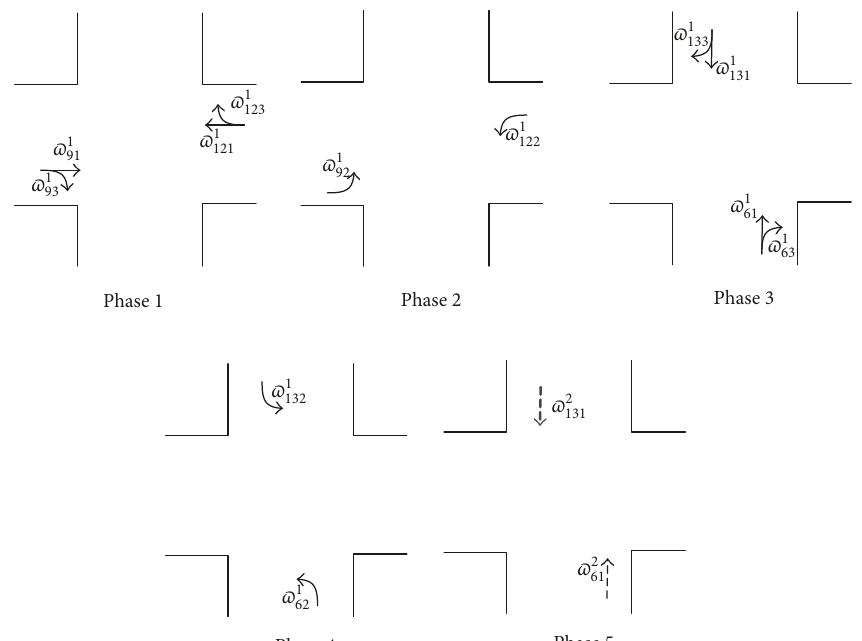
Figure 3: Five-phase signal control strategy in intersection 4.